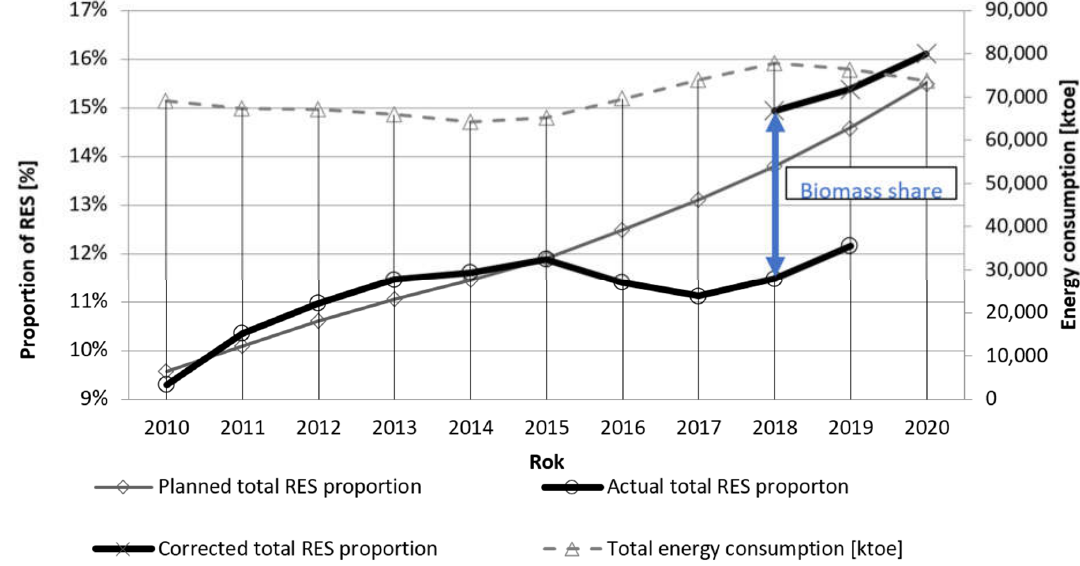
Figure 4. Total and planned share of RES